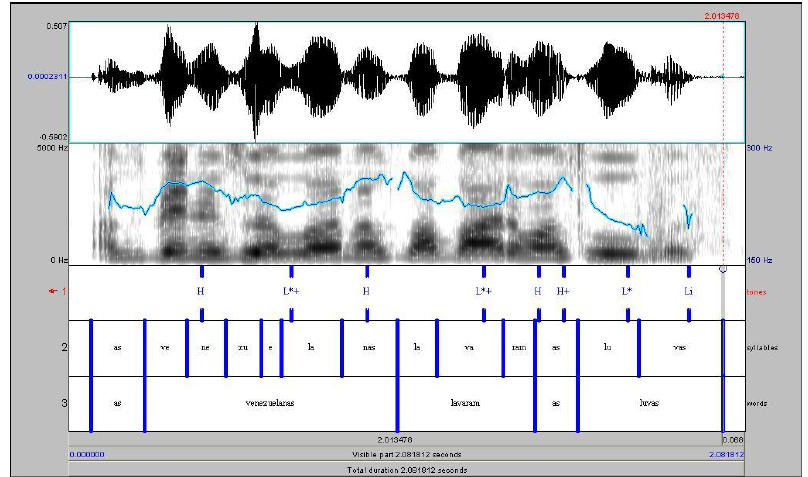
Figure 3. F 0 contour of the neutral sentence As venezuelanas lavaram as luvas ‘The Venezuelans washed the gloves’ produced by G in neutral context.